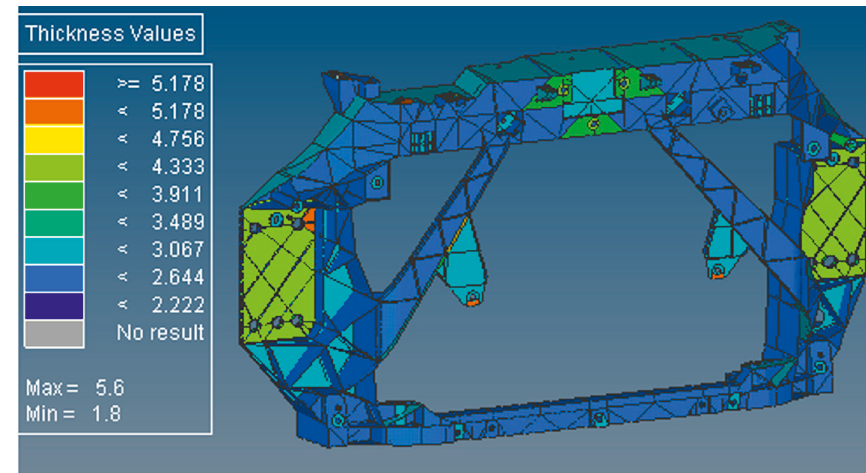
Figure 17: Thickness setting result.